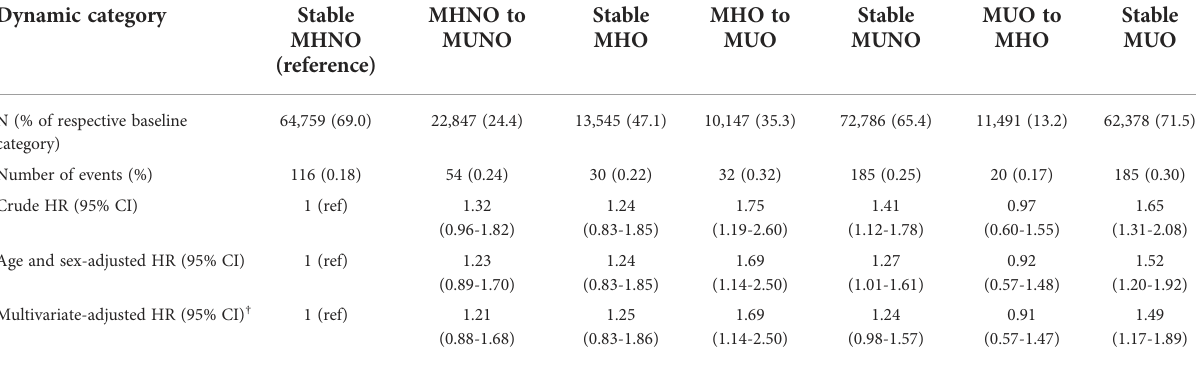
TABLE 3 Risks of incident kidney cancer according to the transition from metabolically healthy to unhealthy status among participants with obesity in reference to the stable MHNO group. Dynamic category Stable